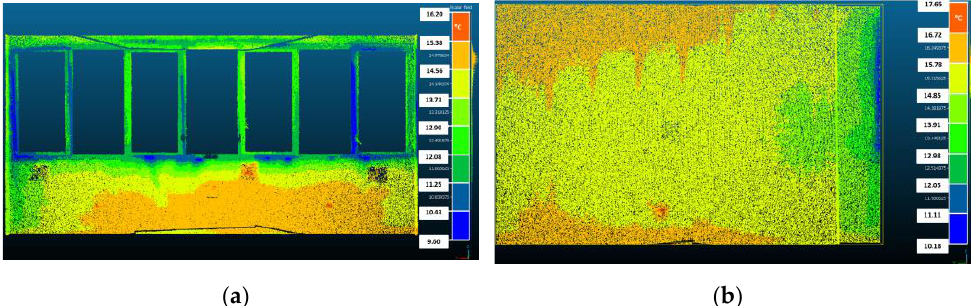
Figure 8. Thermographic ortho-images obtained from the 3D thermal point cloud with real calculated temperatures: ( a ) indoor surface of the west wall of zone W, 10:00 h 19 November 2021; ( b ) indoor surface of the south wall of zone W, 10:00 h 19 November 2021. The colour palette changes with the temperature in steps of 0.4 °C to facilitate the visualisation of thermal surface differences.